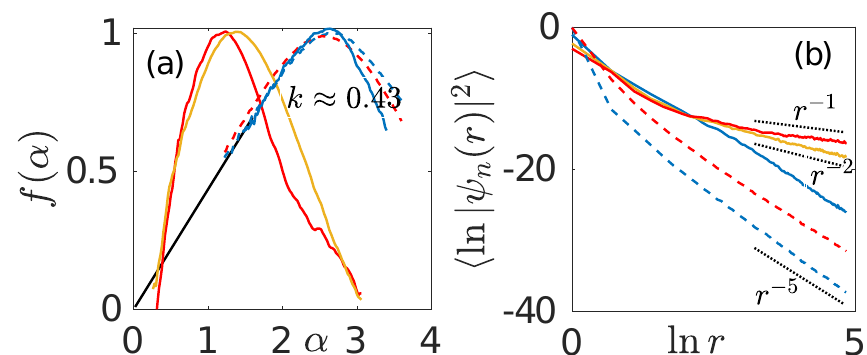
Figure 6: Spatial properties in the spectral bulk. (a) spectrum of fractal dimensions f ( α ) and (b) power-law spatial decay of eigenstates in the bulk of the spectrum for a = 1.5 (solid), 2.5 (dashed), and β = 1 (blue), 1.5 (yellow), 2 (red). The panel (b) confirms the duality of power-law spatial decay rate γ ( a ) ≈ γ ( 2 d − a ) [ 15–17 ] in the localized phase ( β < a < d or a > d ), also supported by the slope k < 0.5 of f ( α ) in panel (a). f ( α ) is extrapolated from L = 75, 100, 125, 150, 200, 225 and 250 with the corresponding number of disorder realizations from 2000 for L ≤ 125 to 300 for L ≥ 225, see Sec. 4.2.1 for details. and with the disorder amplitude W = 20. For the spatial decay L = 250 and W = 20 for a = 1.5, for a = 2.5 we choose bigger W = 200 in order to make the power-law tail dominant on moderate sizes.